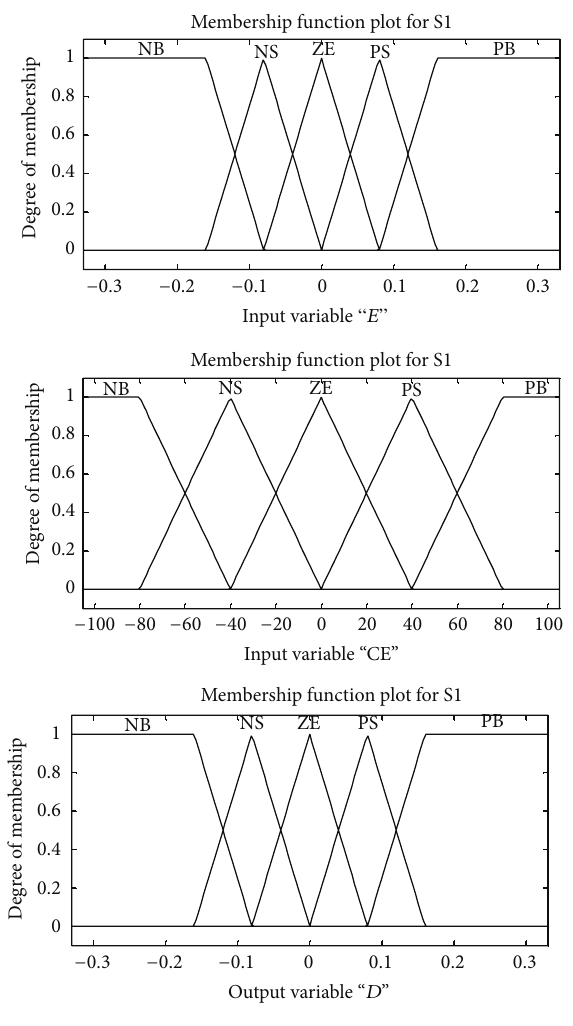
Figure 9: The membership functions of 𝐸 , CE, and 𝐷 for